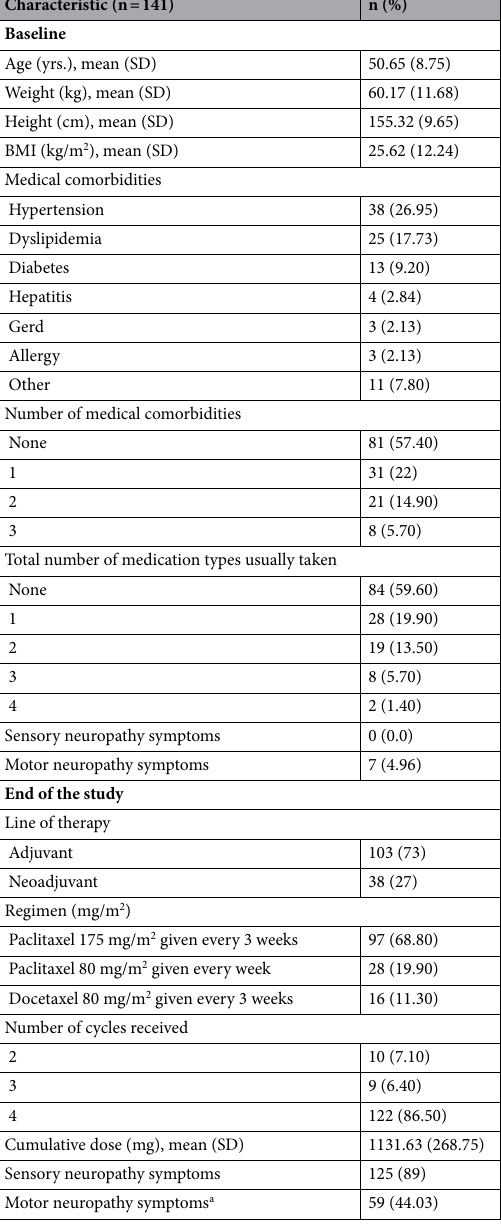
Table 1. Demographic and clinical characteristics of the participants. a n =